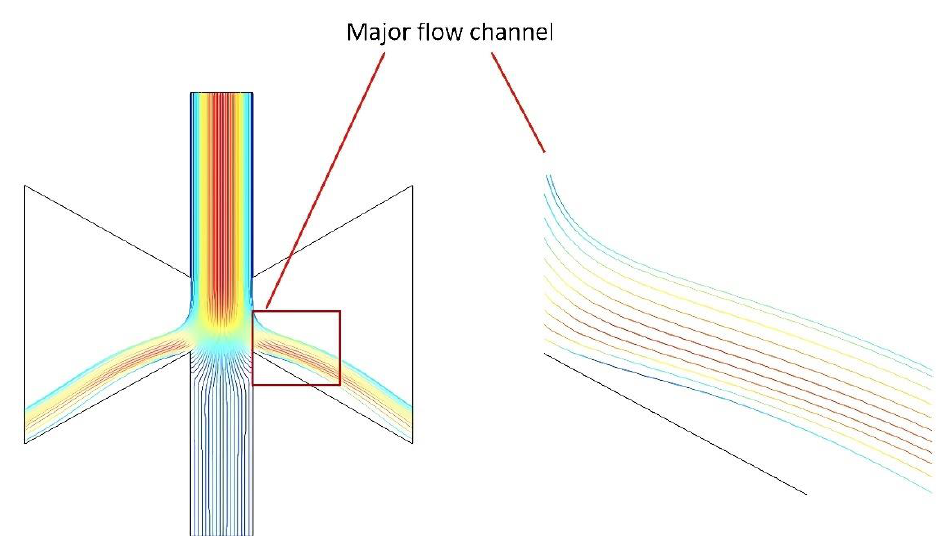
Figure 9. Wall loss on the major flow channel.